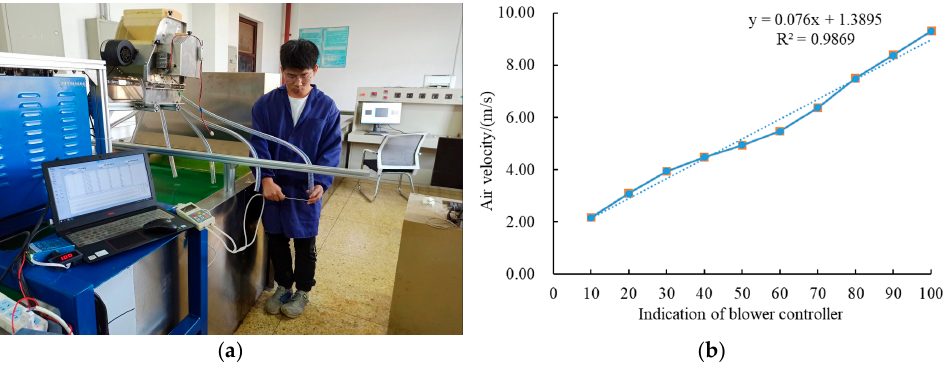
Figure 13. ( a ) Calibration process of airflow velocity; ( b ) fitting results of airflow velocity.